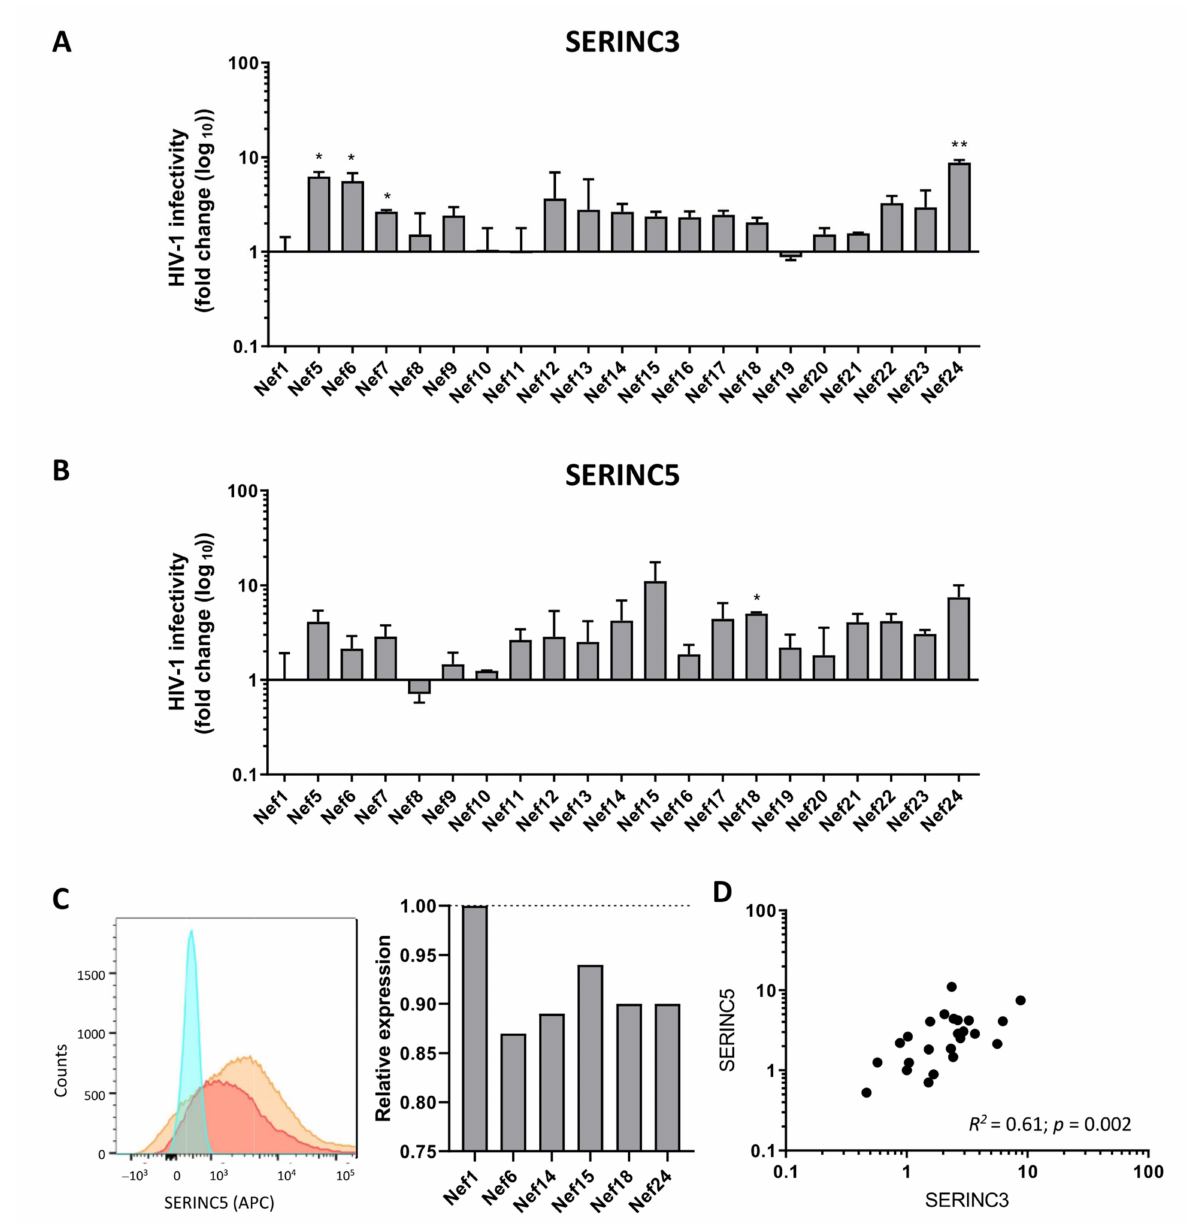
Figure 4. Effect of naturally occurring amino acid variations on infectivity of Bal26-pseudotyped HIV-1. Infectivity of Bal26 Nef-deficient single-round luciferase reporter virus produced in 293T cells overexpressing SERINC3 ( A ) or SERINC5 ( B ) in the presence of wild-type NL4-3 Nef (Nef1) or Nef proteins obtained from individuals with HIV-1 (Nef5-Nef24). The infectivity of the virus produced in the presence of the Nef and SERINC3/5 was corrected for the infectivity of the virus produced in the presence of the same primary Nef and an empty vector. Virus infectivity is expressed relative to the virus produced in the presence of NL4-3 Nef (fold change). Means ± SD of three independent experiments are shown. Unpaired two-tailed t -test (* p < 0.05; ** p < 0.01). ( C ) Downregulation of SERINC5 membrane expression by primary Nef proteins was determined by flow cytometry (Left panel—orange: Nef1; red: Nef24; blue: background fluorescent control). Downregulation of SERINC5 membrane expression by primary Nef (Nef6, 14, 15, 18, and 24) relative to NL4-3 Nef (Nef1) (right panel). ( D ) Correlation between the ability of the primary Nef proteins to counteract SERINC3 and